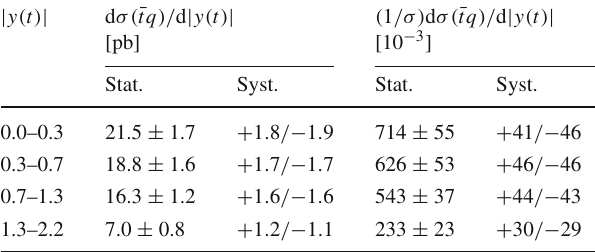
Table 21 Absolute and normalised unfolded differential ¯ tq production cross-sections as a function of | y ( t ) | at parton